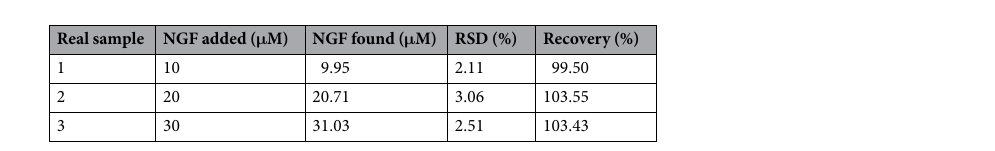
Table 1. Determination of NGF in urine samples (n =